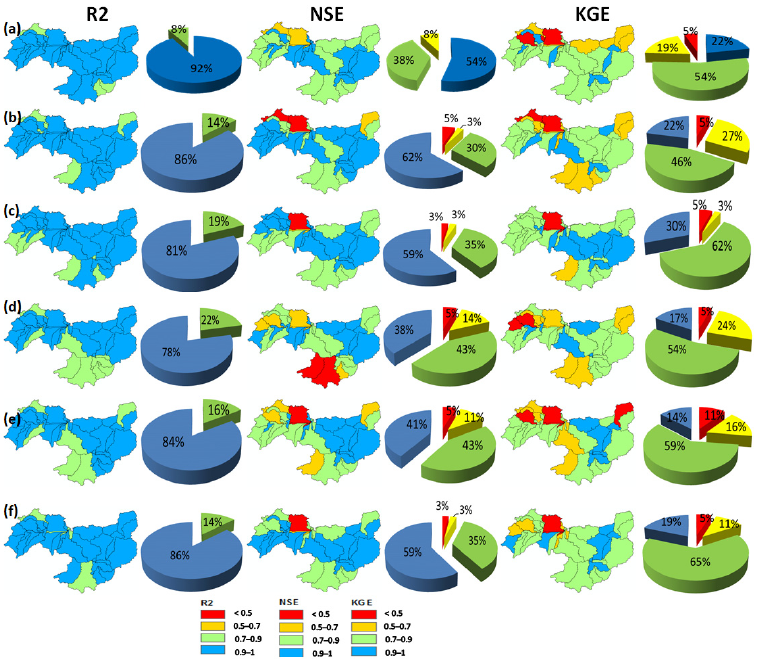
Figure 5. Spatial distribution of performance metrics (R 2 , NSE, and KGE) of SWAT_Hargreaves when validated against ETMonitor in 2010, 2011, 2012, 2013, 2014, and 2015 ( a , b , c , d , e , f ), respectively, in the study area in the Lake Chad Basin.